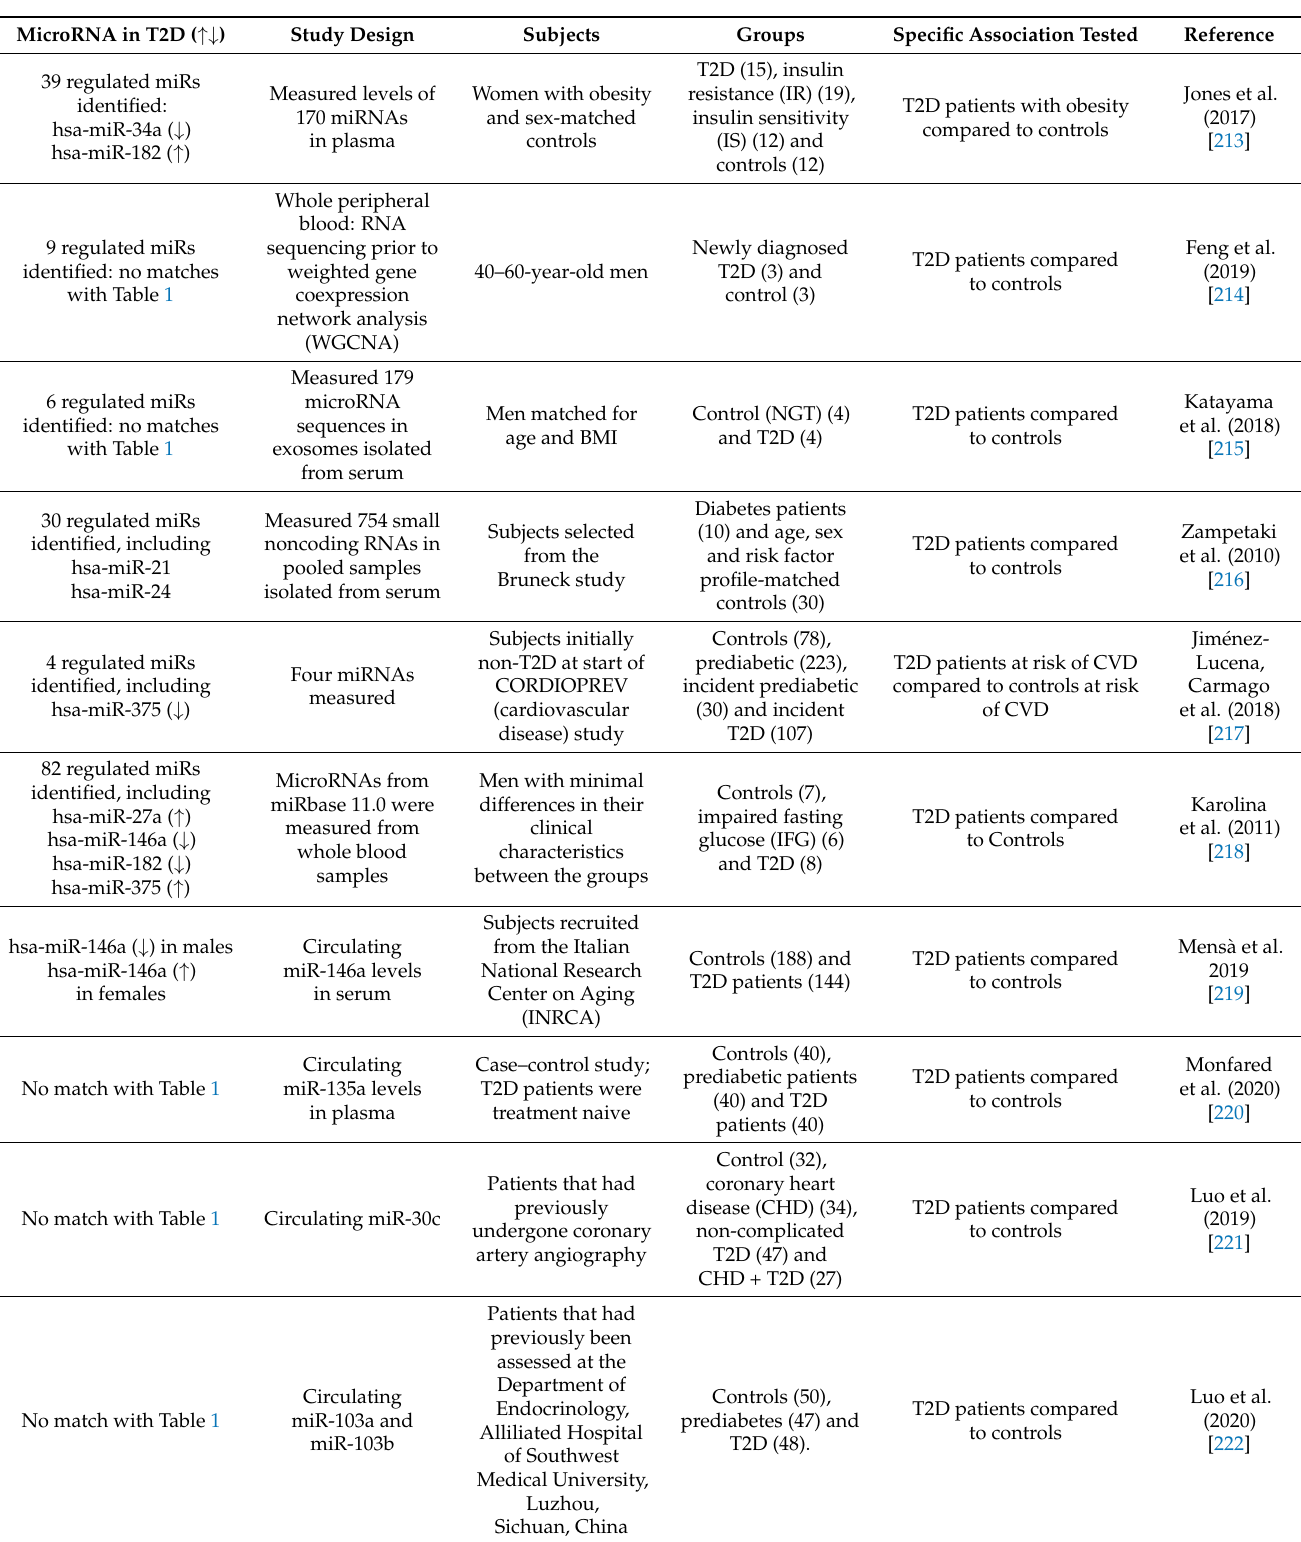
Table 2. Circulating biomarkers of diabetes, cross-referenced to microRNA sequences modified by metabolic challenges in beta cells. Upregulation ( ↑ ) or downregulation ( ↓ ) is noted next to the microRNAs. MicroRNA in T2D ( ↑↓